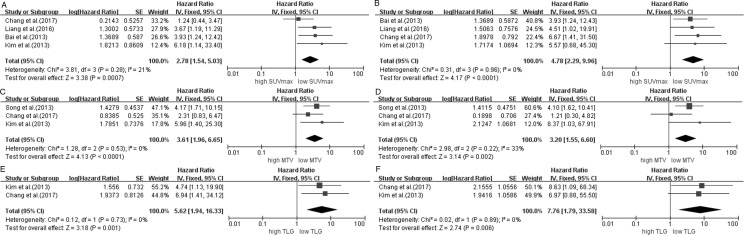
Forest plots of HR for PFS and OS with SUVmax (A, PFS; B, OS), MTV (C, PFS; D, OS) and TLG (E, PFS; F, OS) on B-PET/CT.